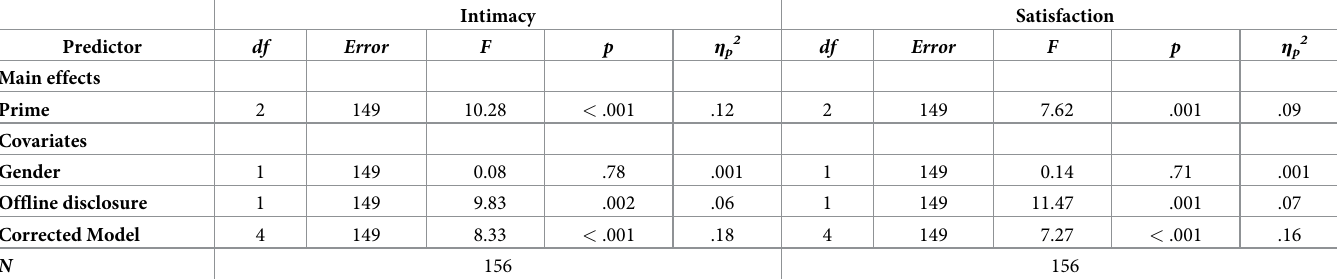
Table 6. Study 5 ANCOVA models predicting relationship intimacy and